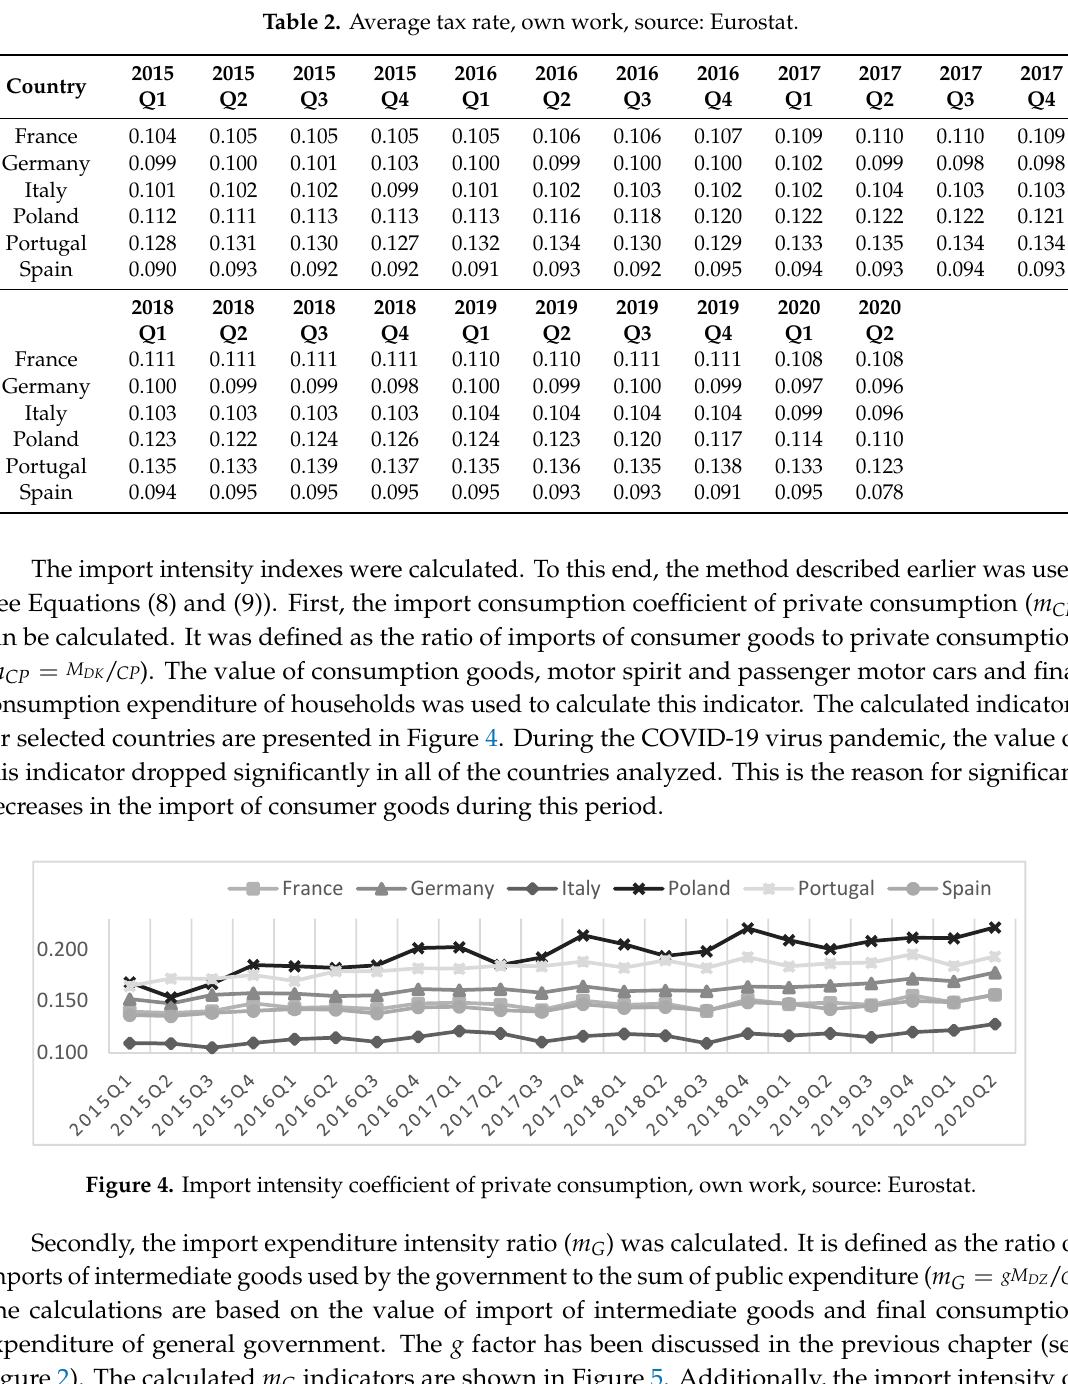
Figure 5. Import intensity coefficient of public expenditure, own work, source: Eurostat. Next, the private investment intensity of import ( (cid:1865) (cid:3010)(cid:3017) ) was calculated. In the previous chapter it was described as (cid:1865) (cid:3010)(cid:3017) = (cid:1839) (cid:3005)(cid:3010) + (cid:1853)(cid:1868)(cid:1839) (cid:3005)(cid:3027) (cid:1835)(cid:1842)(cid:3415) . The calculations are based on the value of import of capital goods, import of intermediate goods and final consumption expenditure of general government. The (cid:1868) and (cid:1853) coefficient were discussed in the previous chapter. The results of the calculation are presented in Figure 6. The results of the calculations are like previous import intensity indicators. It turns out that during the COVID-19 virus pandemic, the import intensity ratio also dropped